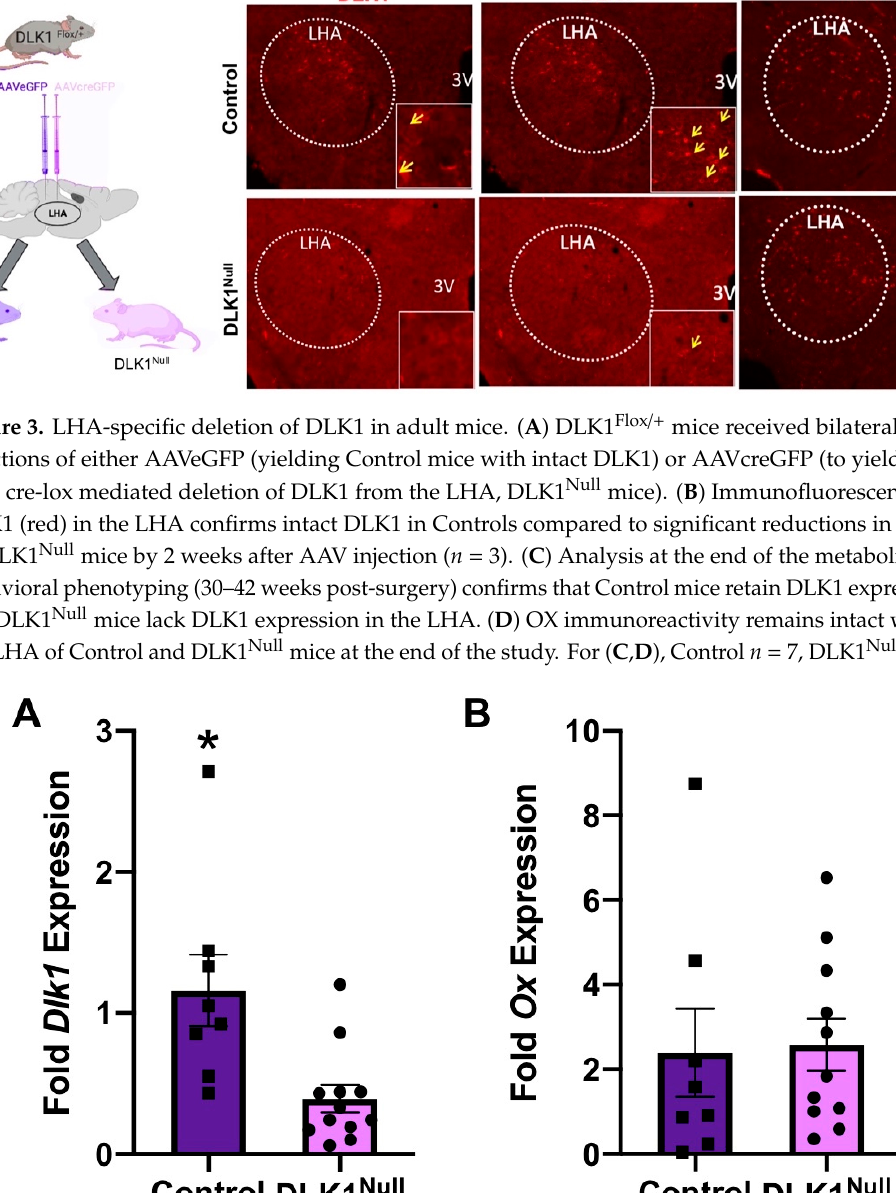
Figure 4. Dlk1 , but not Ox , is depleted in the LHA of adult DLK1 Null mice. ( A ) Control mice have significantly higher fold mRNA expression of Dlk1 within the LHA compared to DLK1 Null mice. ( B ) Control and DLK1 Null mice have comparable Ox gene expression within the LHA. Black squares identify individual Control samples. Black dots represent the individual DLK1 Null samples.* p < 0.05. Control n = 8, DLK1 Null = 11.